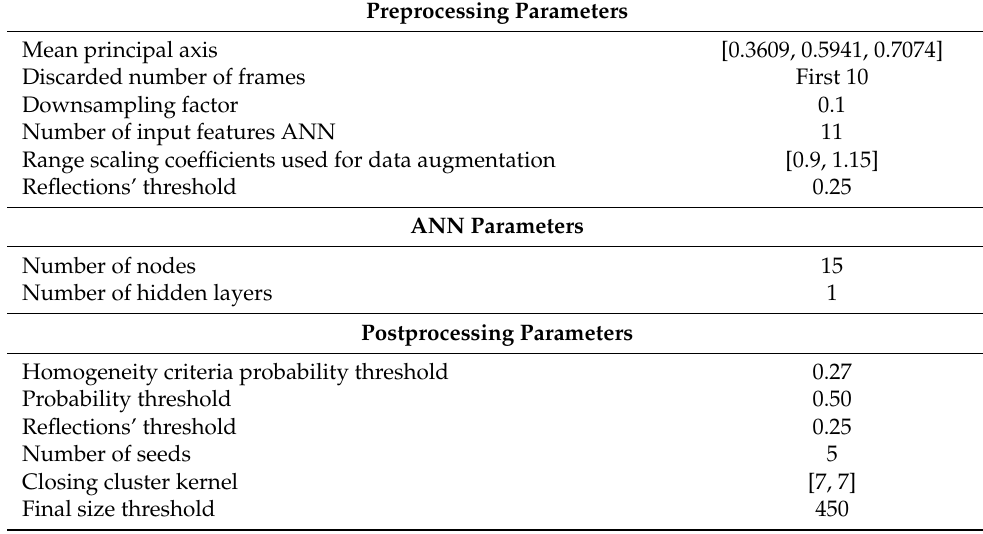
Table 2. Algorithm